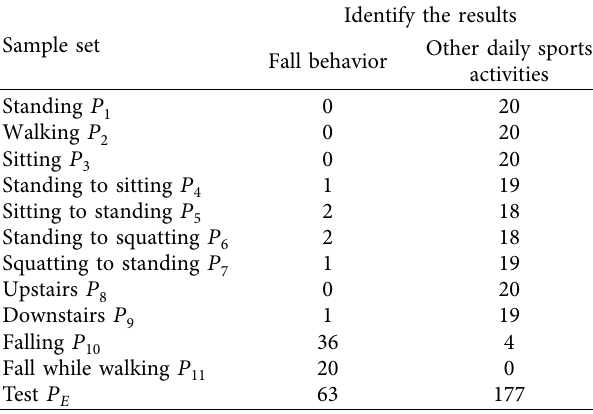
Table 2: Experimental results of Algorithm